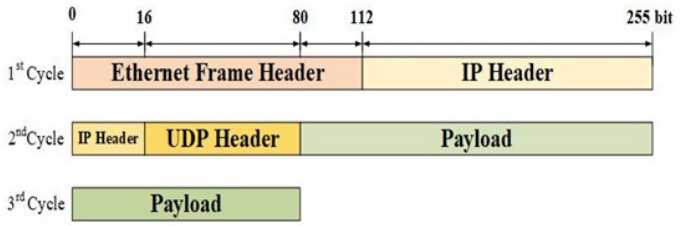
Figure 3. Requesting packet format.